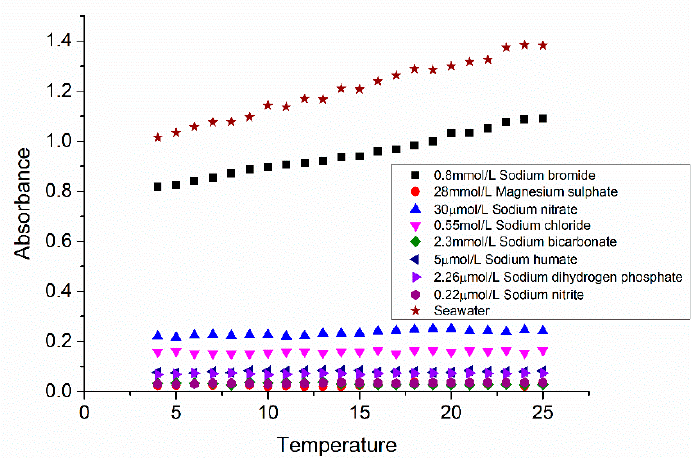
Figure 5. Relationship between absorbance and temperature of pure solutions and seawater at 210.029 nm.